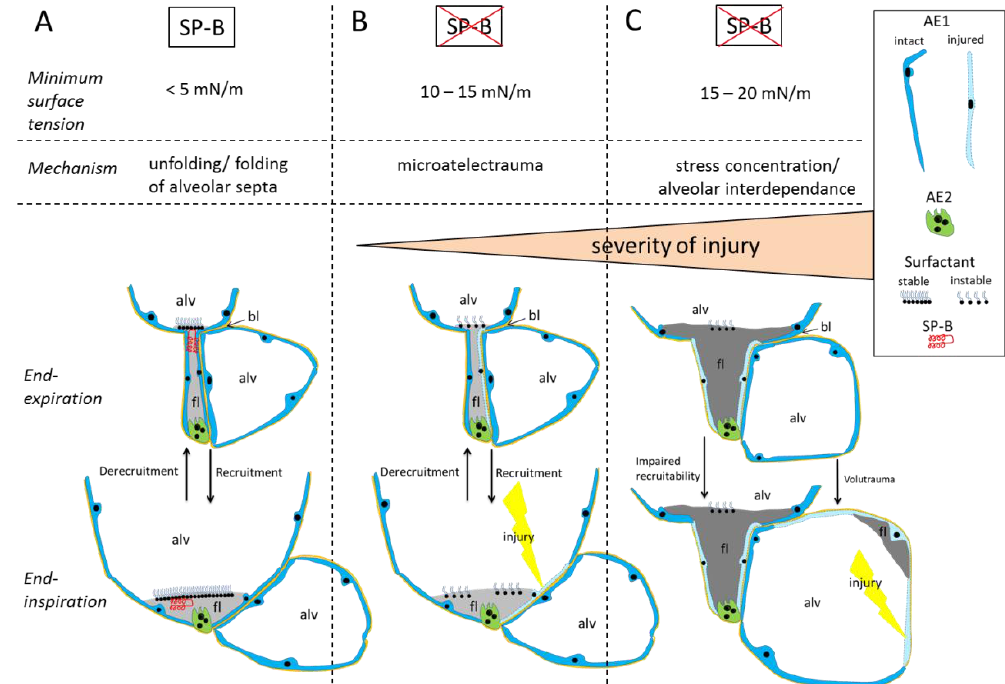
Figure 8. Proposed mechanism of lung injury in SP-B deficiency: Under physiological conditions ( A ) volume changes during ventilation include recruitment and derecruitment of folds. At low lung volumes folds are filled with a very thin leaflet of alveolar fluid (fl), the surfactant monolayer is compressed at the air-liquid interface and stabilized by SP-B. With increasing lung volume the folds are recruited and the fluid is pressed into the corners of the alveoli. The fluid-mechanical stress during this opening process acting on the alveolar epithelium is reduced by surface lowering properties of surfactant [22,39]. In absence of SP-B (indicated in B and C by the red cross) the monolayer is unstable, the minimum surface tension increases within 24 h [21]. The opening process of folds ( B ) is linked with harmful stresses acting on the alveolar epithelial cells (microatelectrauma) [22,39]. The blood- gas barrier is compromised by the progressing injury and the volume of alveolar fluid and plasma protein levels increase. High surface tension combined with increased viscosity of alveolar fluid reduces the recruitability of folds ( C ). Heterogeneous ventilation with overdistension of neighboring alveoli (alveolar interdependence) occurs with leakage of the blood-gas barrier in adjacent alveoli. Abbreviations: AE1: alveolar epithelial type 1 cell, AE2: alveolar epithelial type II cell, fl: alveolar fluid, bl: basal lamina, alv: alveolar airspace.